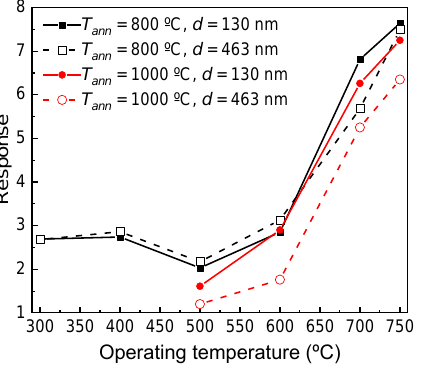
Figure 5. Dependences of the response to 40 vol. % O 2 on operating temperature.